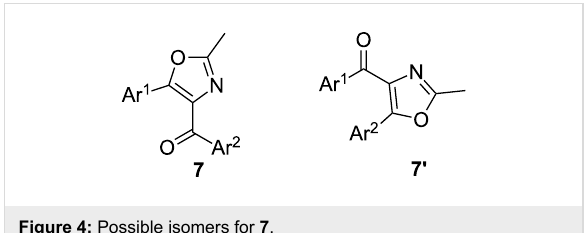
Figure 4: Possible isomers for 7